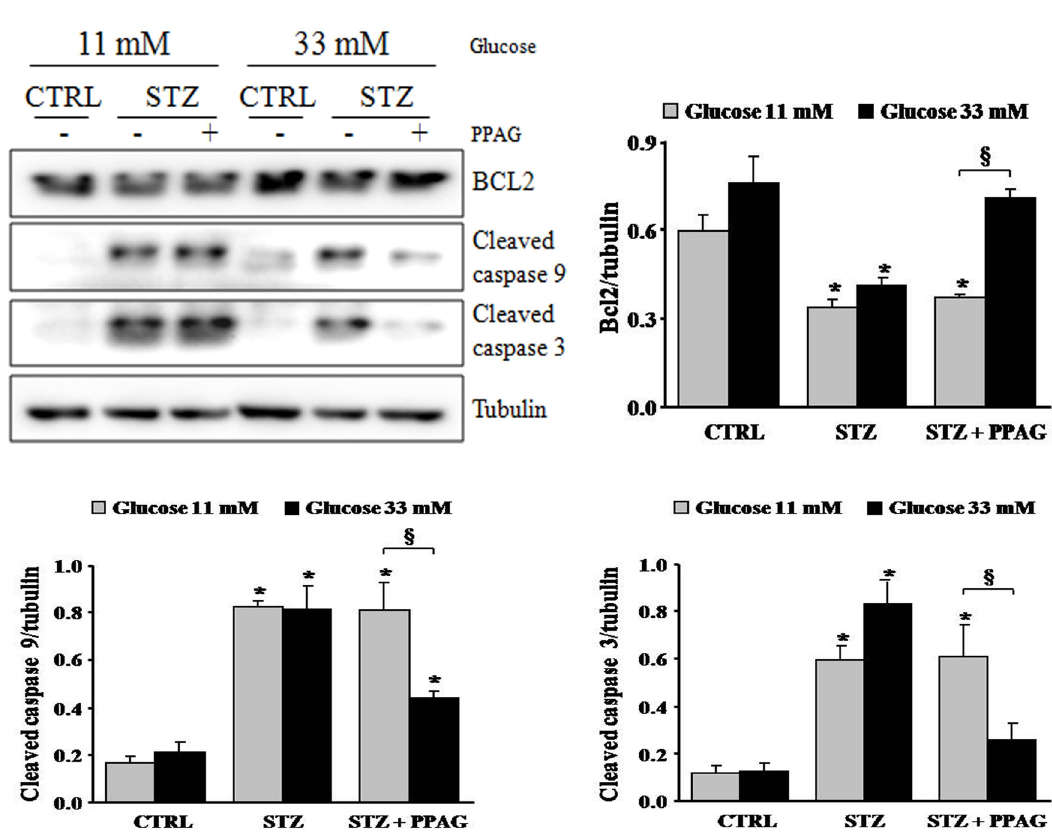
Fig 4. Expression of caspases and BCL2. Western blot and densitometry for BCL2 and cleaved caspase 9 and 3 in INS-1E cells pre-treated with 30 μ M PPAG for 16 hours, exposed to 1 mM STZ for 1 hour and then cultured for 7 hours in medium containing 11 or 33 mM glucose with or without PPAG (n = 3). * p < 0.05 against control (CTRL). §p < 0.05 as indicated.